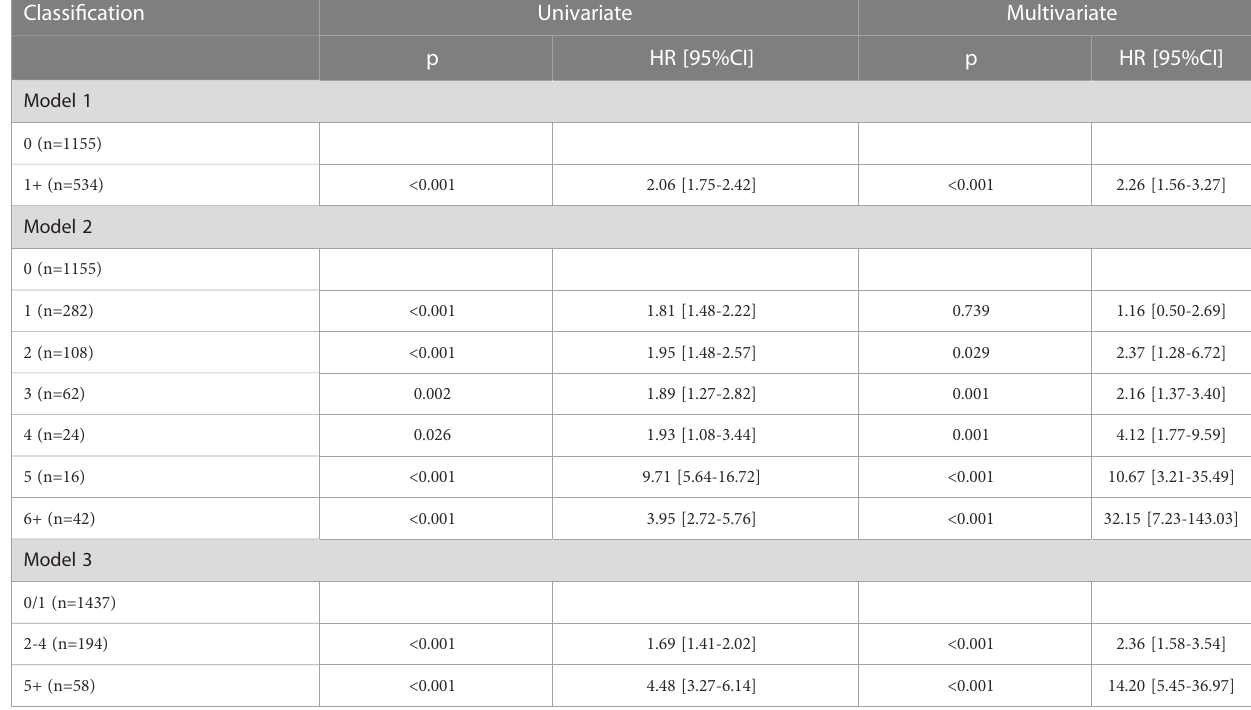
Model 1 con fi rmed that LN metastasis is an independent predictor of DSS and OS. However, it referred to the metastasis of intraparotid or neck LN, both of which signi fi cantly decrease survival. Han et al. (10) analyzed the association between cervical LN involvement and OS in 54 patients and found that node status TABLE 4 Univariate and multivariate Cox analysis of the impact of number of positive lymph nodes on overall survival. Classi fi